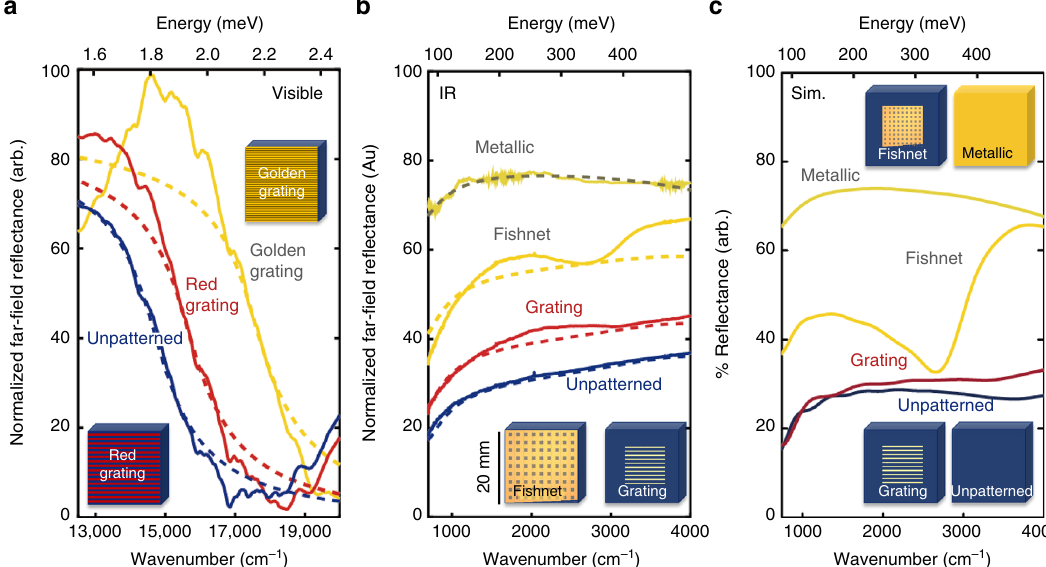
Fig. 3 Tuning the far- fi eld response of SmS metamaterials in the visible and IR range. a Re fl ectance spectra (solid lines) of golden visible MM grating and red visible MM grating, compared to an unpatterned semiconducting reference at 295 K. The data are fi t (dashed lines) using the Drude dielectric model, which shows the shift of the plasma edge. b IR spectra (solid lines) of a fi shnet and grating MM as well as reference unpatterned semiconducting and metallic (golden) surfaces at 295 K. The data are fi t using effective medium theory (dashed lines), indicating the overall re fl ectance change is a function of metallic fi ll fraction. Schematics of the 20 × 20 μ m regions of the fi shnet (lower left) and grating (lower right) are shown in the inset. c CST simulations